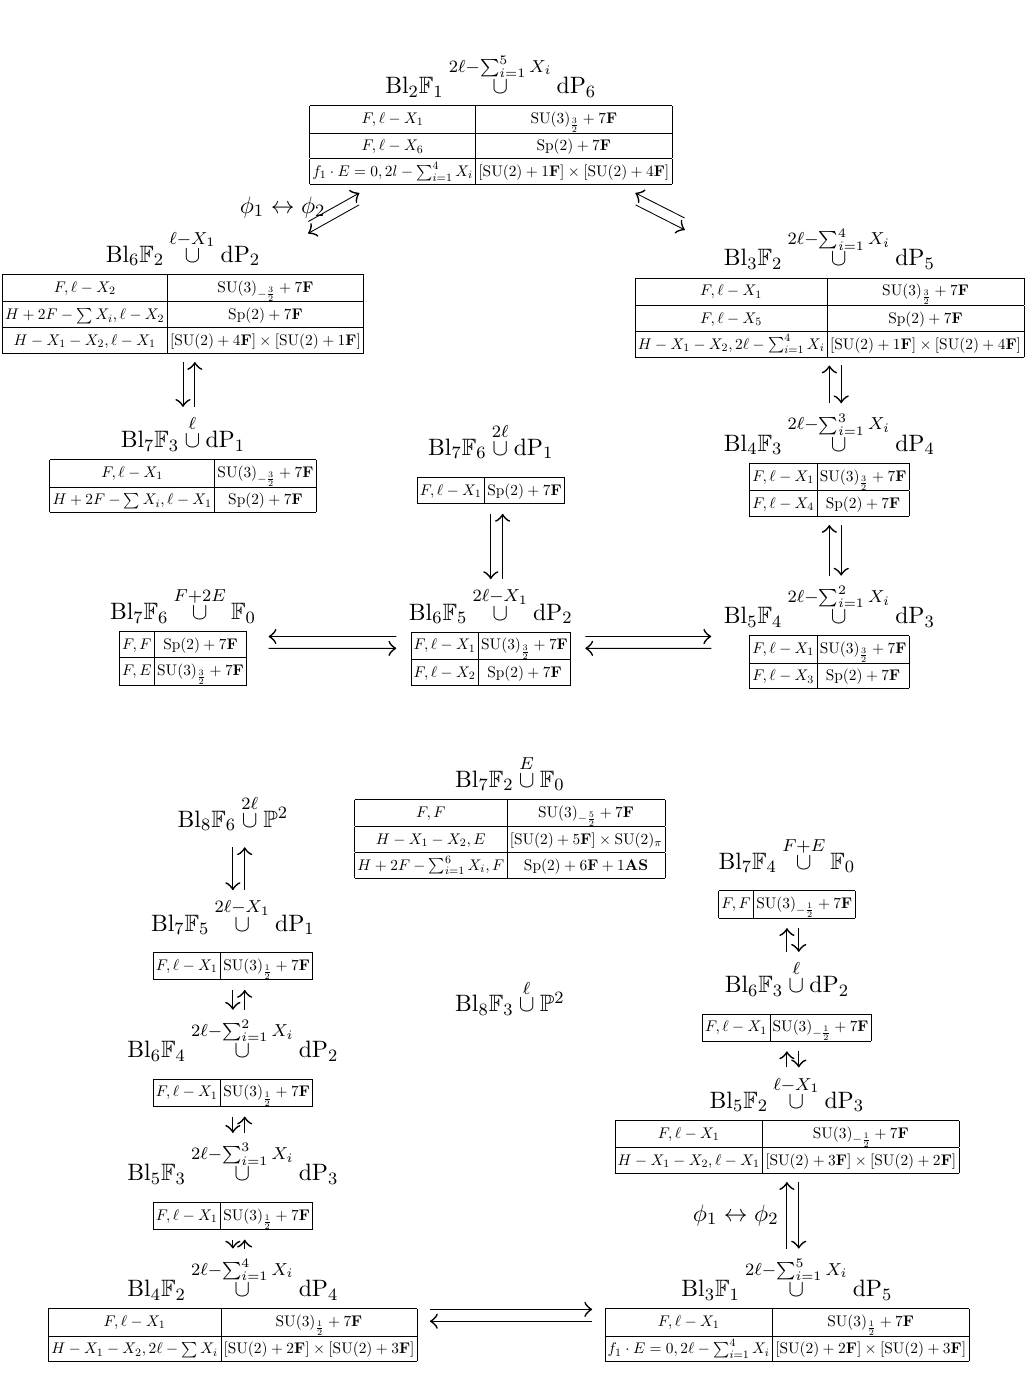
Figure 13. M = 8 geometries. (See footnote 18 for a comment about Bl 8 F 3